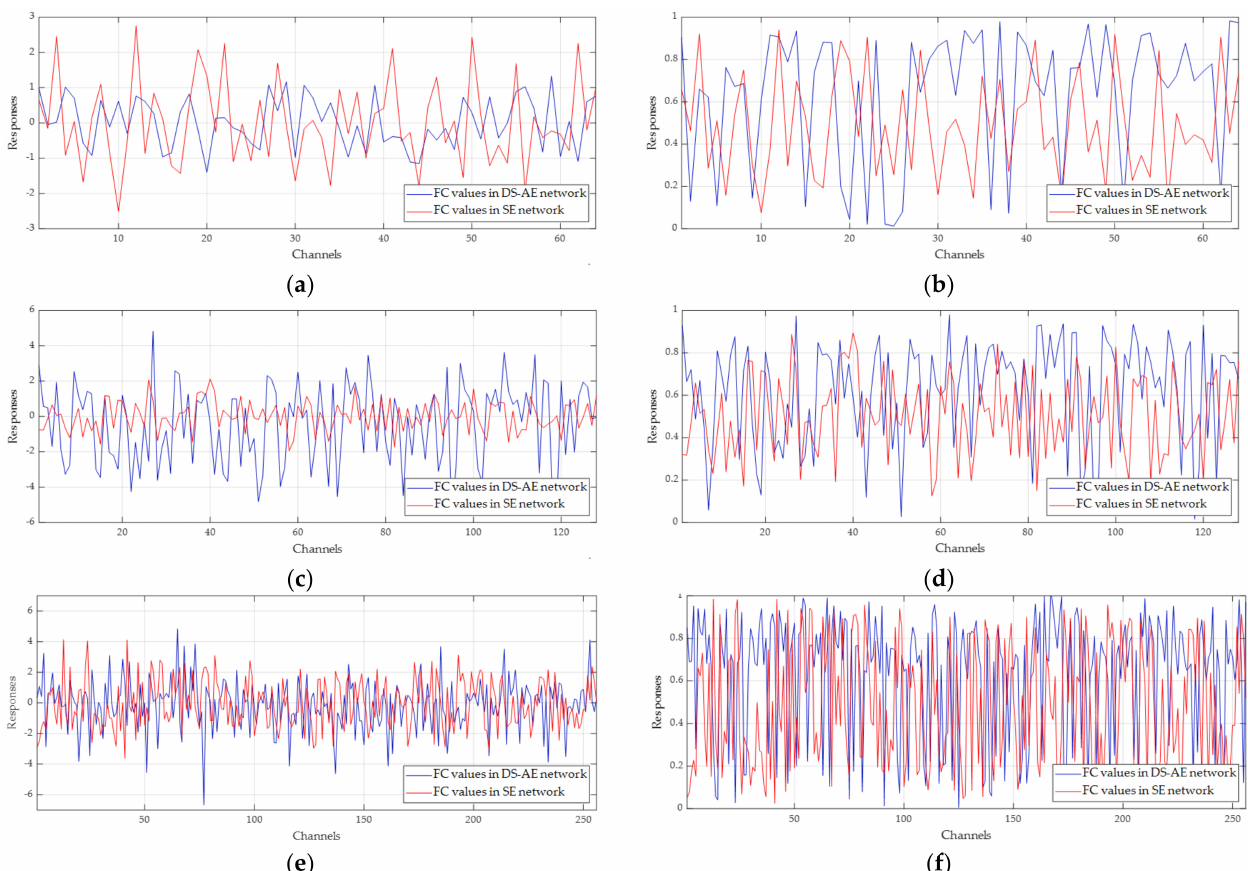
Figure 11. Channel excitation vectors from the DS-AE network (blue line) and the SE network (red line) for stages 1, 2, and 3. ( a ) Channel excitation vectors at the output of stage 1 before excitation; ( b ) channel excitation vectors at the output of stage 1 after excitation; ( c ) channel excitation vectors at the output of stage 2 before excitation; ( d ) channel excitation vectors at the output of stage 2 after excitation; ( e ) channel excitation vectors at the output of stage 3 before excitation; ( f ) channel excitation vectors at the output of stage 3 after